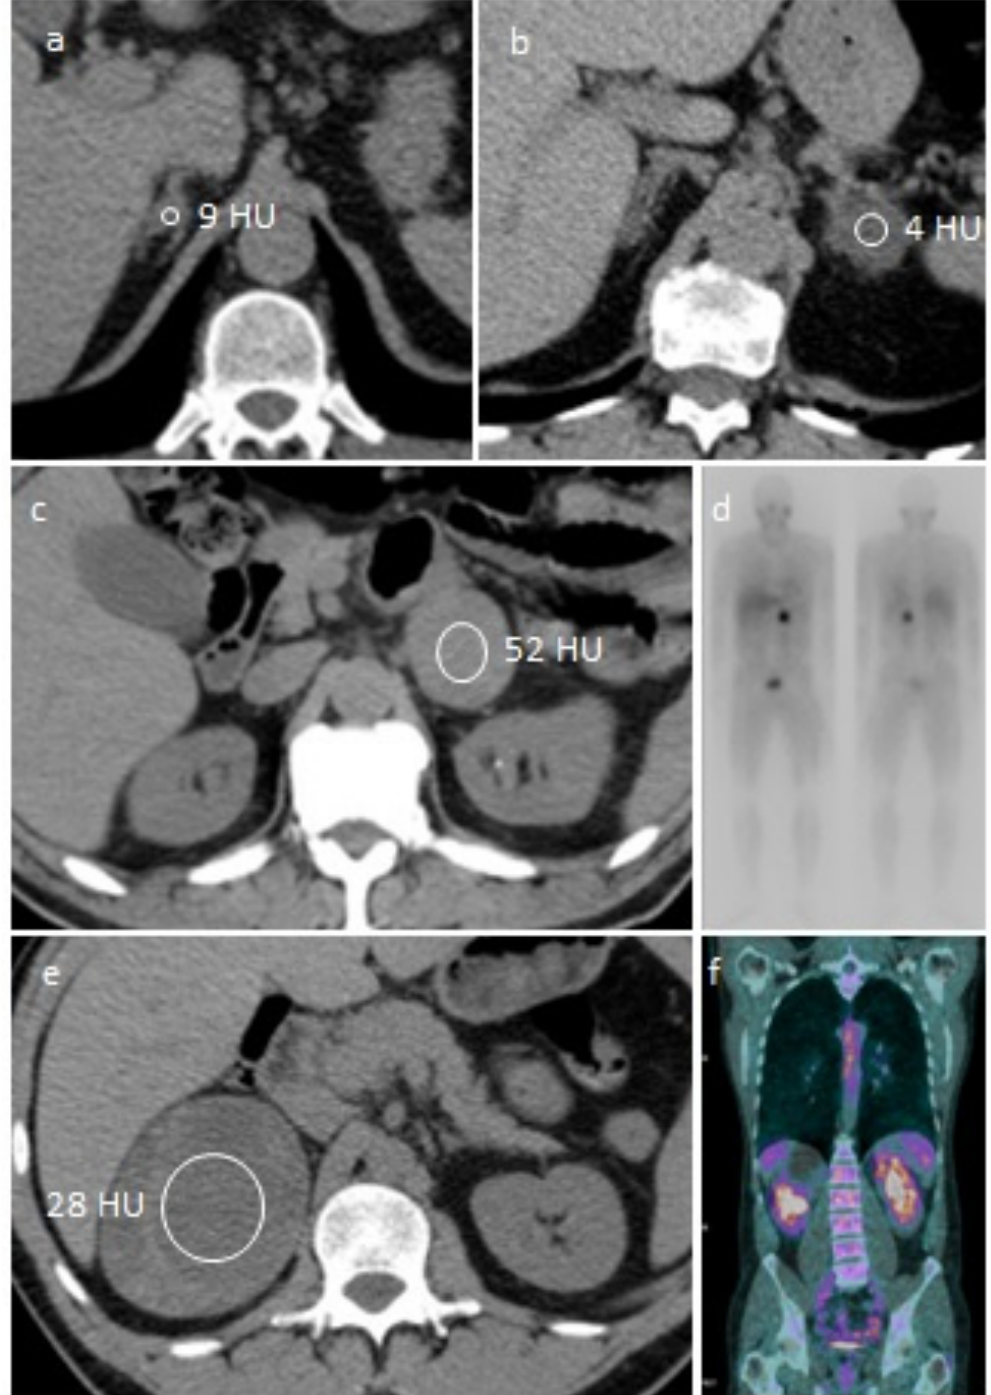
Figure 1. Representative images of the case vignettes. ( a ) CT scan of Case 1: unenhanced CT images show a small lesion with a low attenuation value in the right adrenal gland. ( b ) CT scan of Case 2: unenhanced CT images show a small lesion with a low attenuation value in the left adrenal gland. ( c , d ) CT scan and MIBG scintigraphy of Case 3: unenhanced CT image shows a high attenuation lesion in left gland ( c ) with only adrenal MIBG uptake on subsequent scintigraphy ( d ). ( e , f ) CT scan and 18 F-FDG PET CT of Case 4: unenhanced CT image shows a very large inhomogeneous lesion in right gland ( e ), without extra-adrenal F-FDG uptake on subsequent PET-CT ( f ).